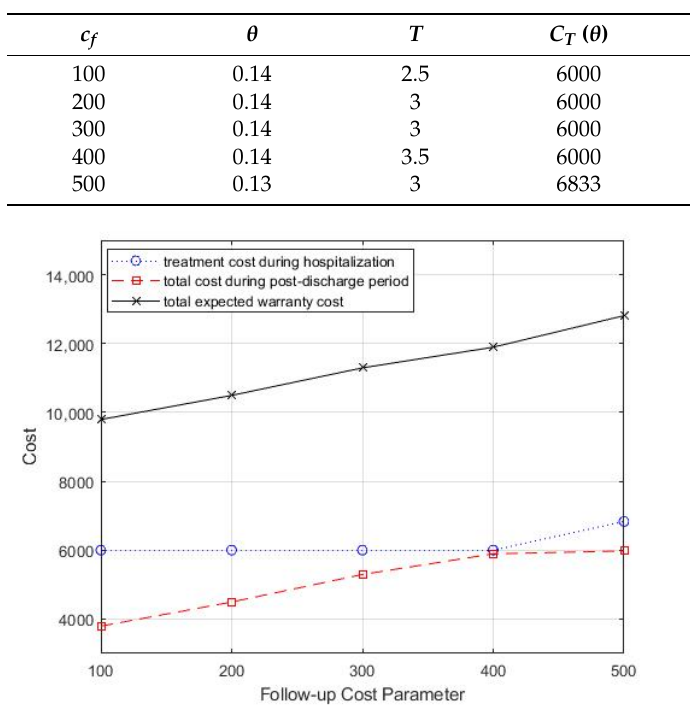
Figure 6. Change in follow-up cost parameter, c f , for total costs.